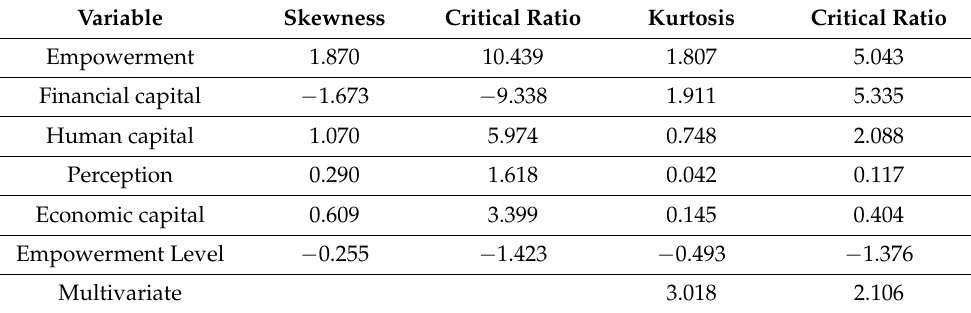
Table 7. Data distribution normality test